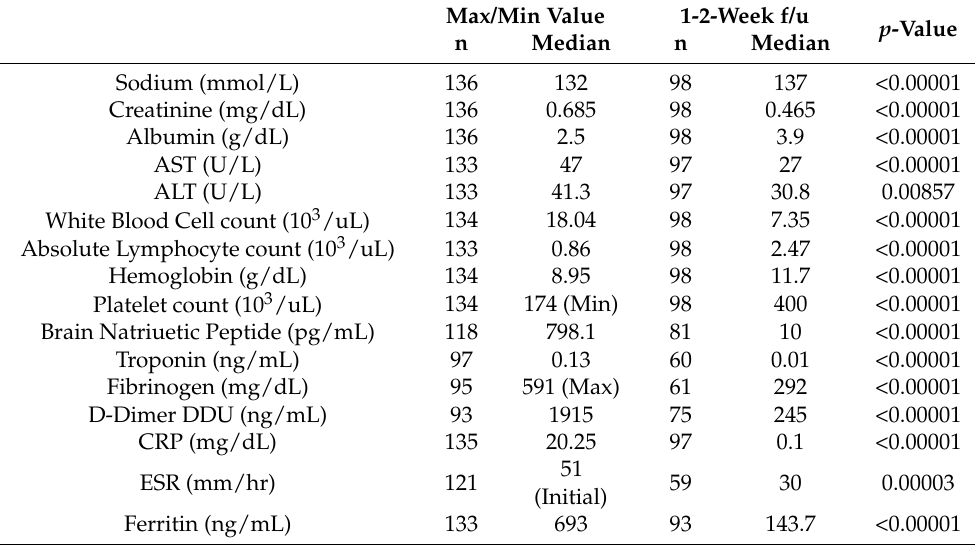
Table 3. Improvement in laboratory findings in all